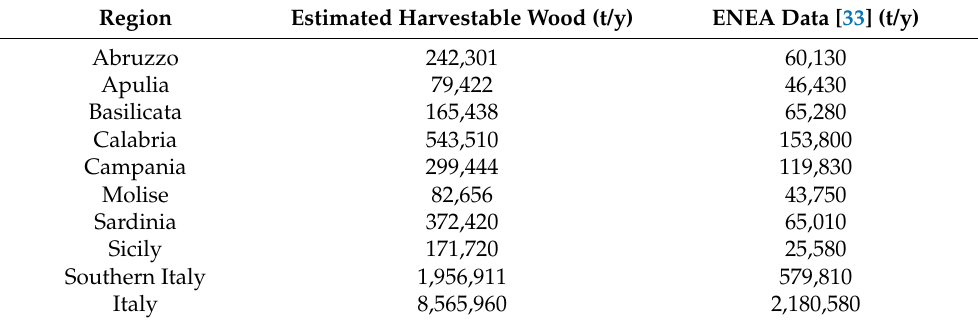
Table 7. Sustainably harvestable forest wood in Southern Italy (partially adapted from ENEA,